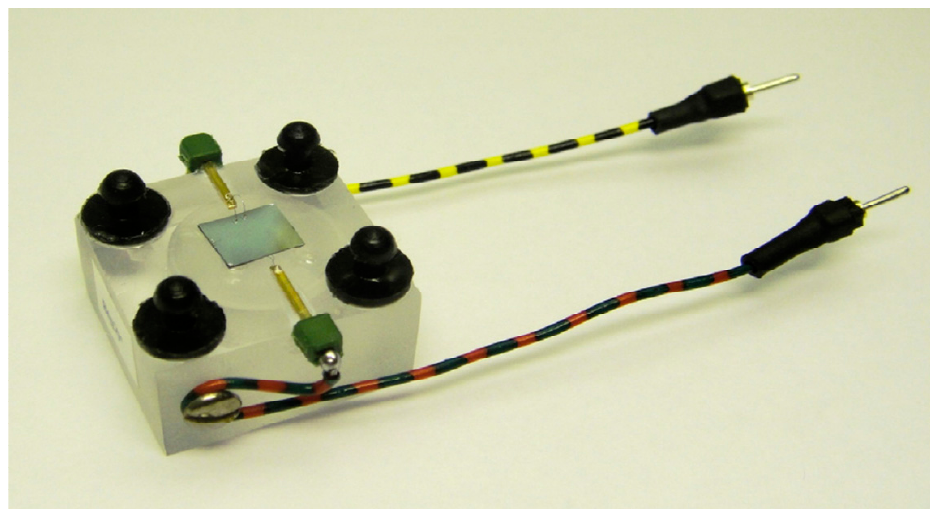
Figure 2. Fixtures required for the construction of ∆ E-E telescope with separated silicon PIN radiation detector [4].